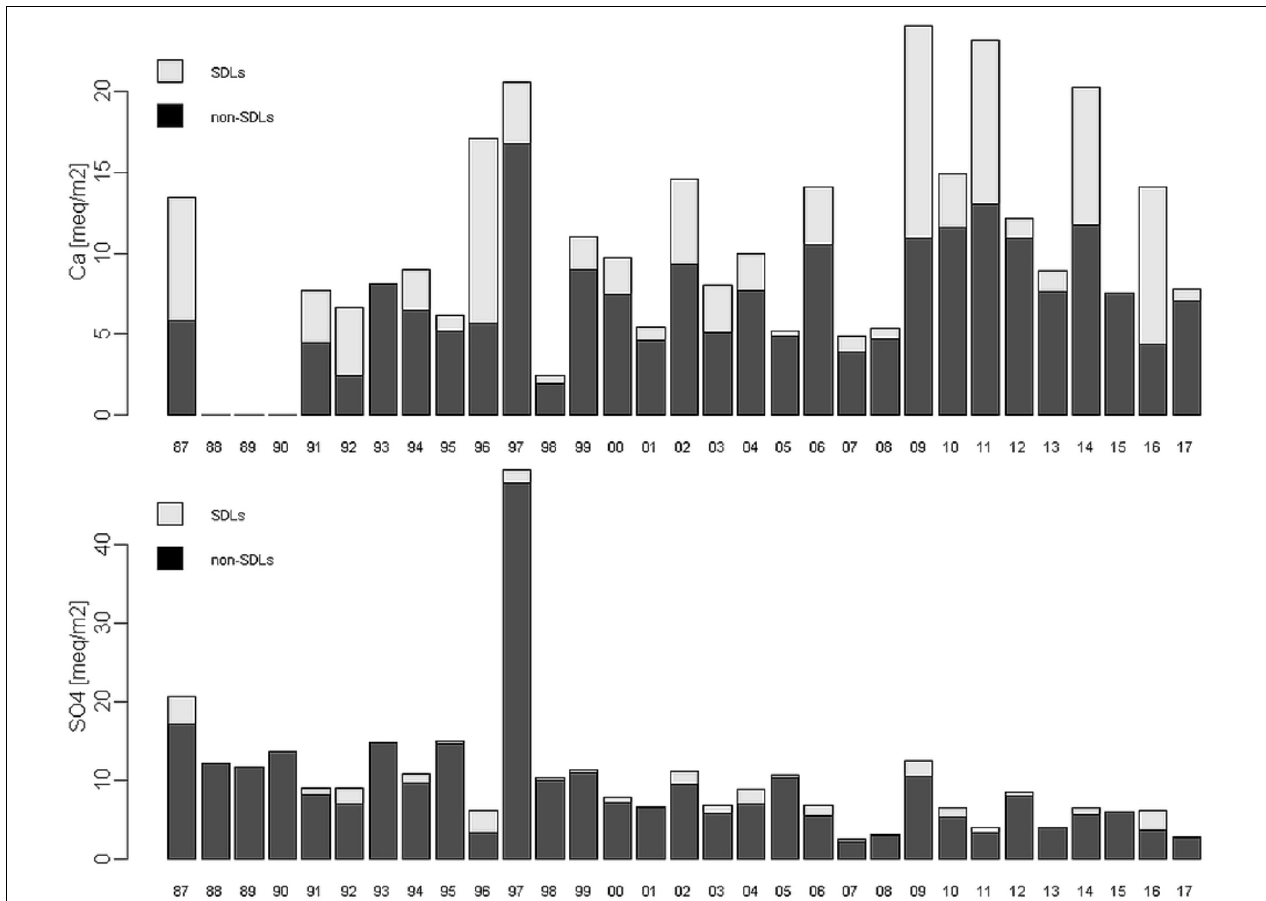
FIGURE 5 | Deposition of Ca 2 + and SO 2 − 4 for all years of observation in meq/m 2 separated in the contribution of Saharan dust layers (SDLs) in gray and non-SDLs in